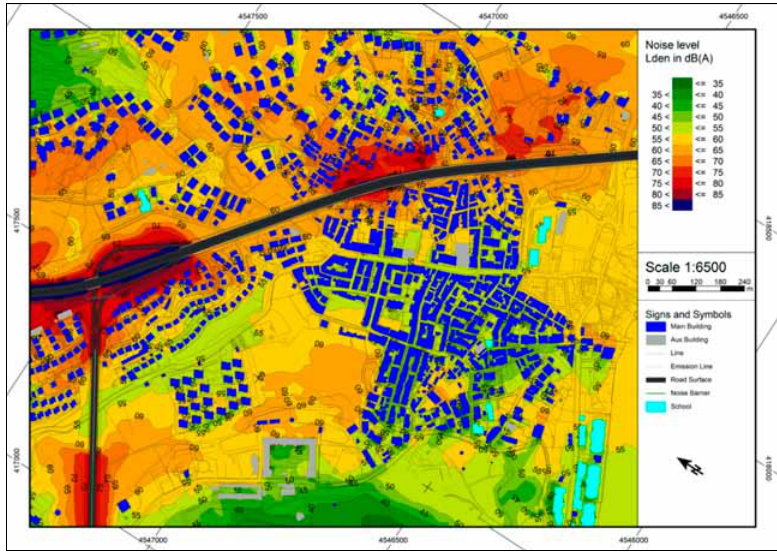
Fig. 6. Bosporus Bridge link road noise map for the day-evening-night average (L with noise barriers